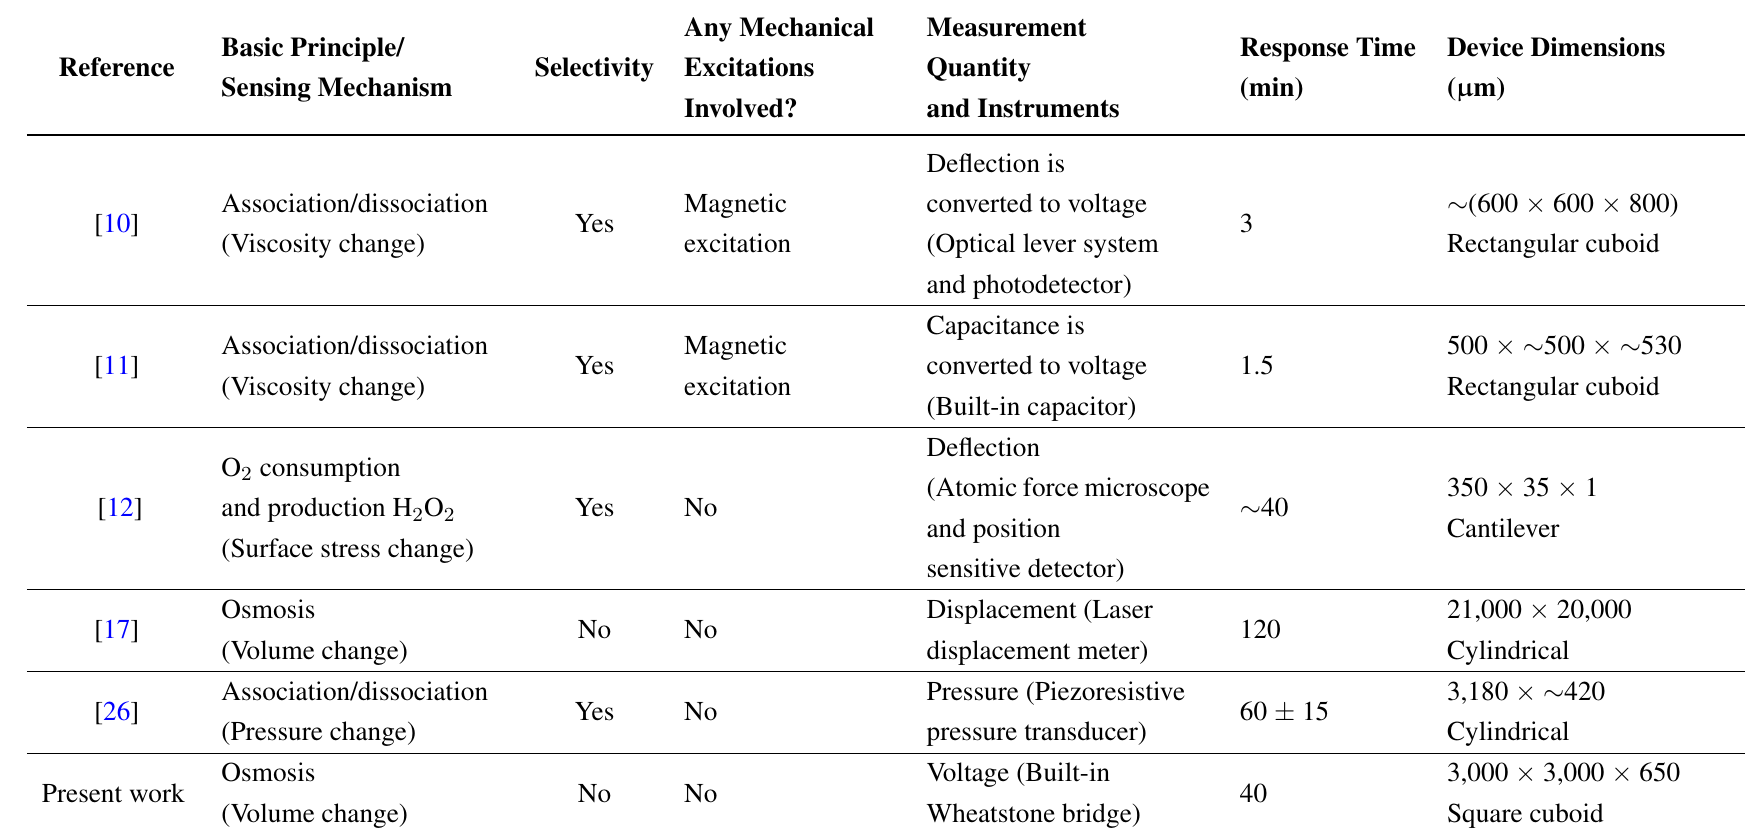
Table 1. Performance comparison of fabricated glucose